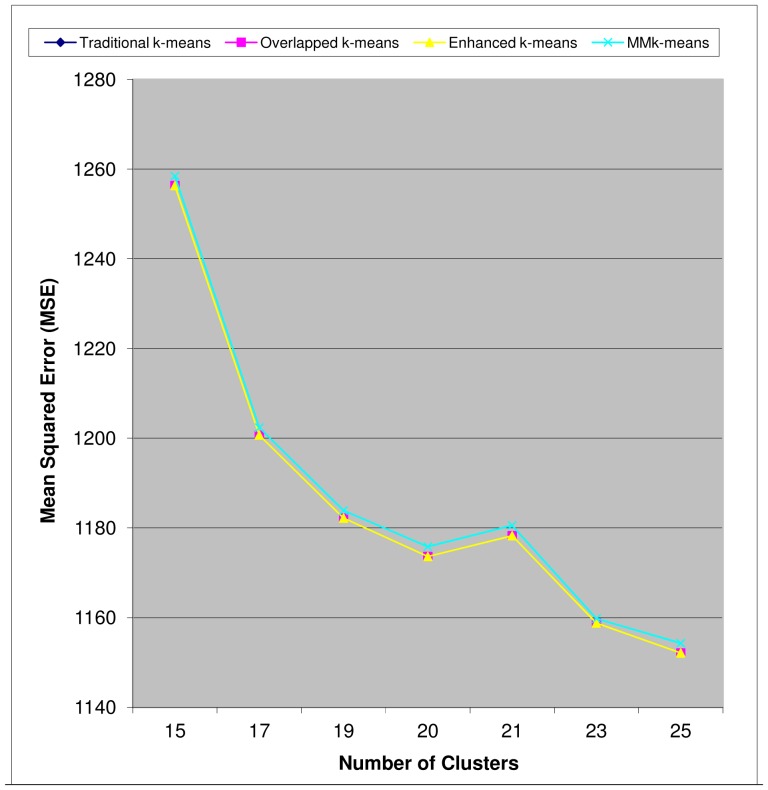
Quality of Clusters (Bozdech et al., P.f 3D7 Microarray Dataset).The qualities of clusters for the four algorithms are similar. The MSE decreases gradually as the number of clusters increases except for k = 21 that has a higher MSE than when k = 20.